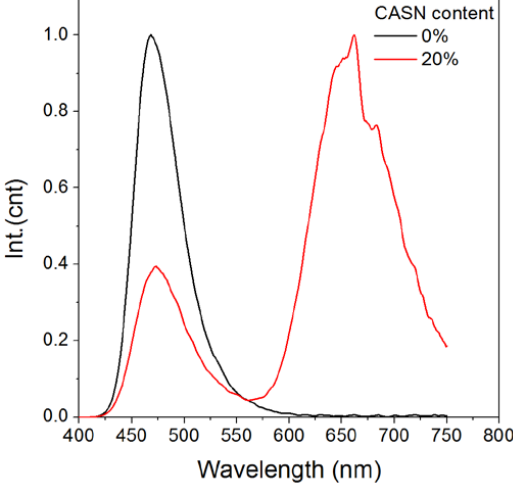
Figure 3. Afterglow emission of SMS and CASN/SMS nanocomposite PMMA (polymethyl methacrylate) film (20% of CASN by weight). Samples are excited by using a violet LED torch (395 nm, 9 w).